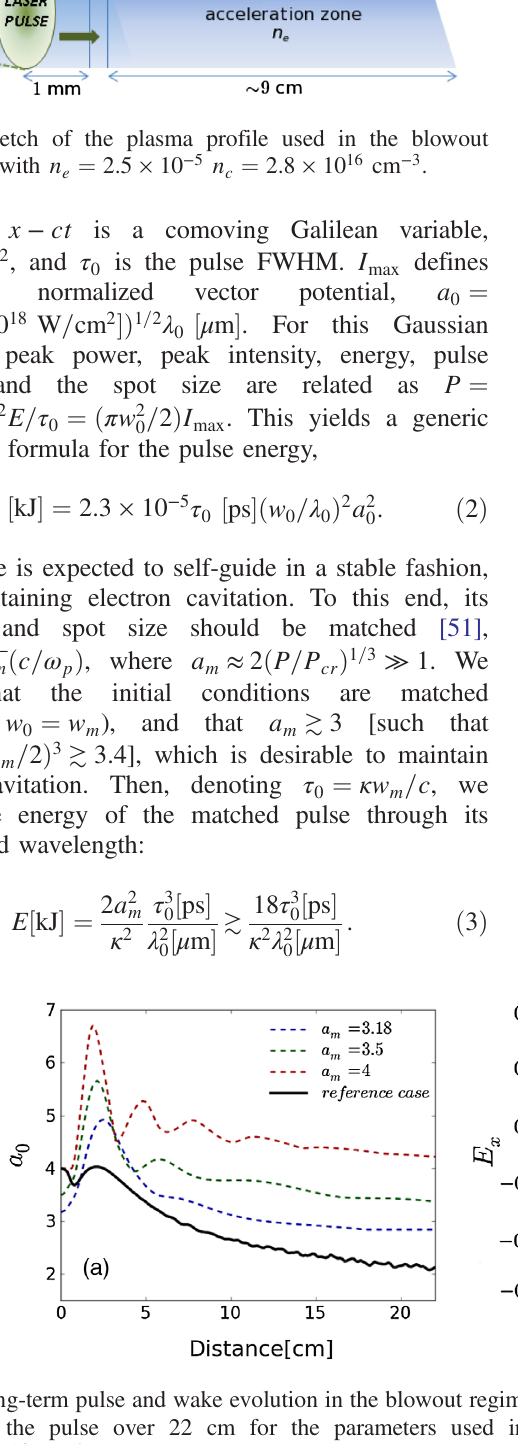
4 and n 6 . 6 × 10 16 cm − 3 (dashed 0 ¼ e ¼ 3 . 18 and n 3 . 3 × 10 16 cm − 3 (dashed blue line). 0 ¼ e ¼